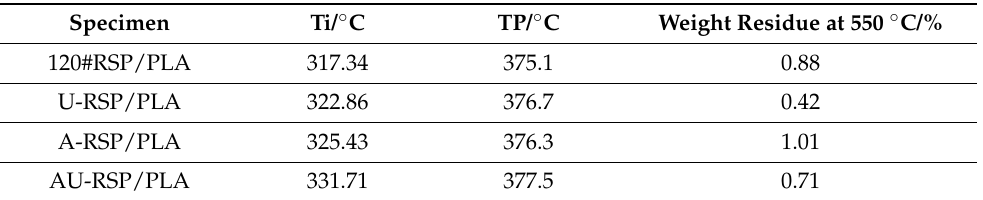
Figure 7. ( a ) TGA curves and ( b ) DTG curves for the samples at 20 K/min in a nitrogen atmosphere. Table 2. Thermal decomposition parameters for 3D-printed unmodified and modified RSP/PLA composites in a nitrogen atmosphere.